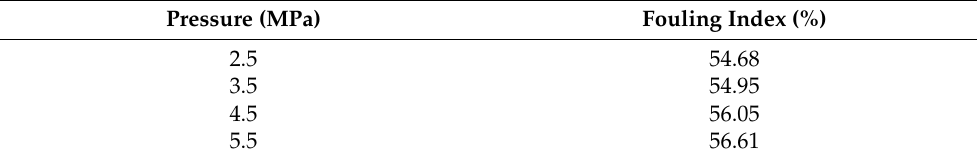
Table 3. Phenolic compounds content of initial conventional Cabernet Sauvignon red wine and re- tentates obtained by reverse osmosis at 2.5, 3.5, 4.5, and 5.5 MPa with cooling and without cooling. TPC Sample (g GAE/L)